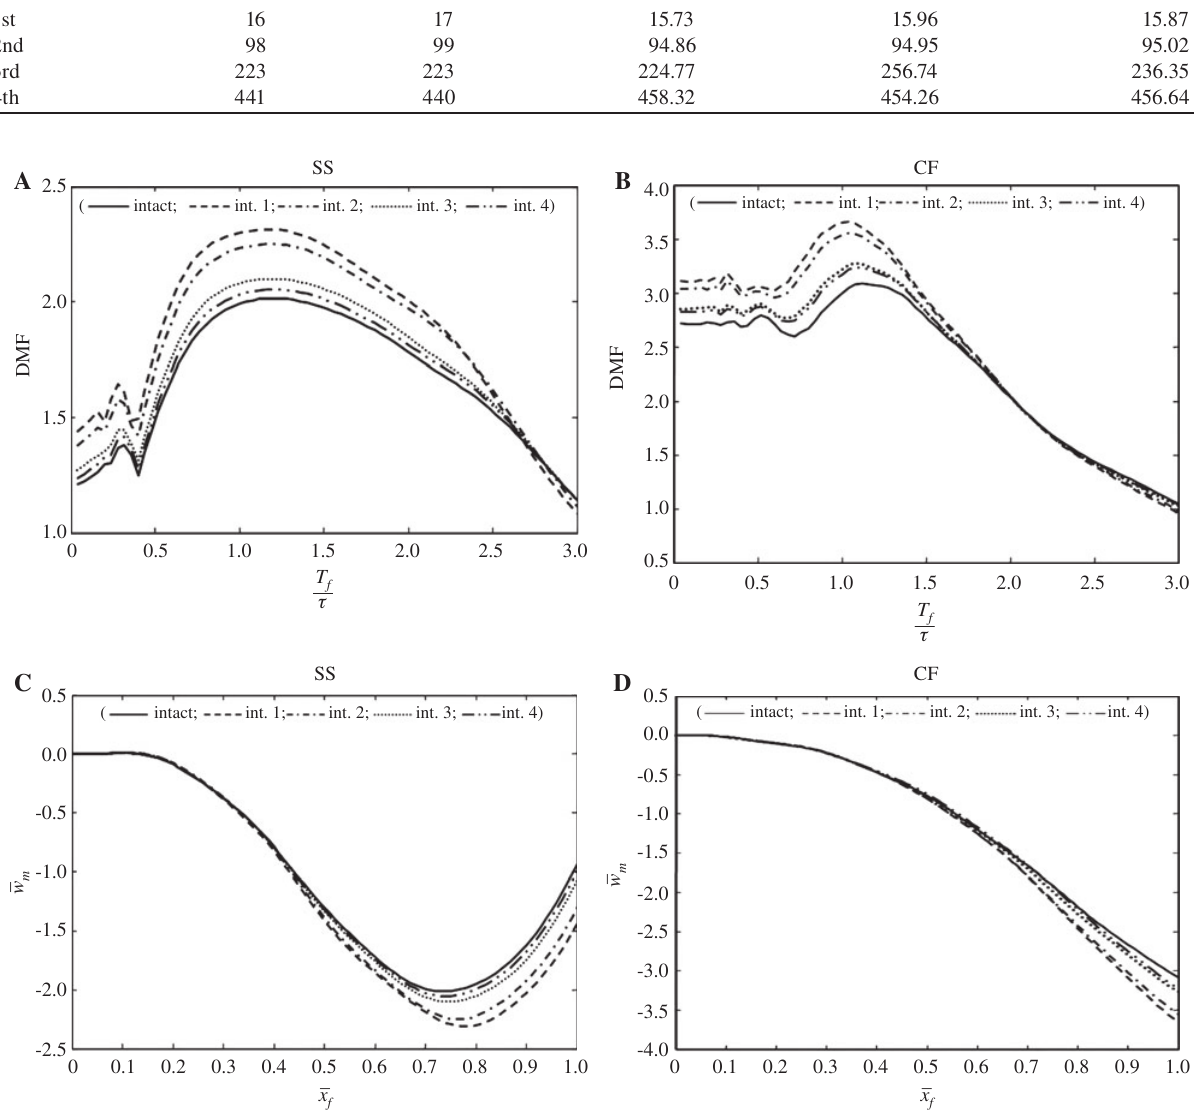
Figure 5 (A, B) Variation of DMF vs. T locations of delamination at load critical velocity (